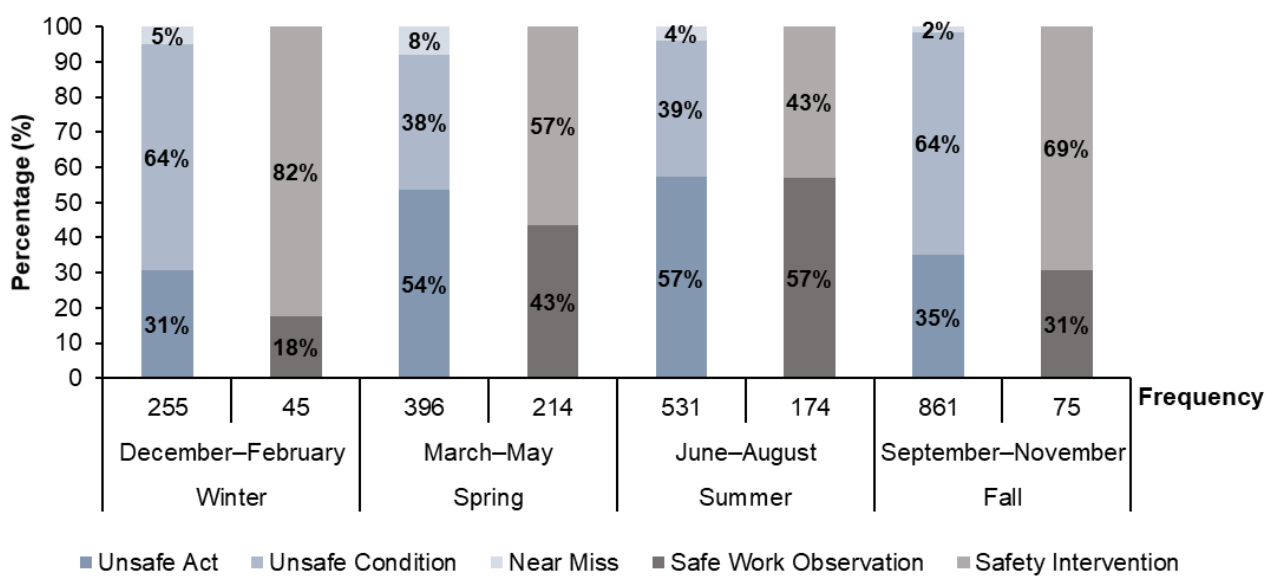
Figure 4. Statistics of safety leading indicators.